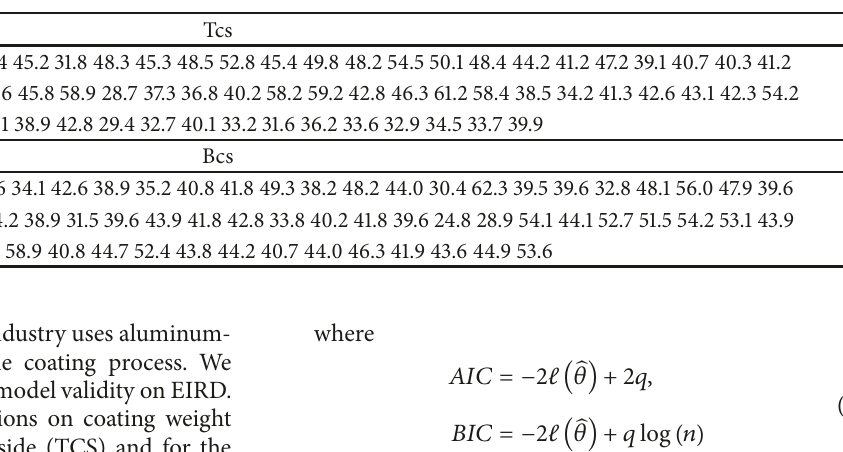
Table 6: Coating weight by chemical method on Tcs and